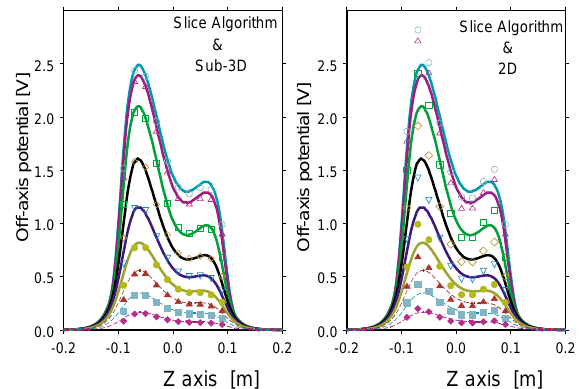
FIG. 11. (Color) On the left-hand side is the longitudinal po- tential of the beam bunch of Fig. 10 inside a metal pipe of ra- dius 2 cm calculated by the slice algorithm of Sec. II (solid and dashed lines) and the sub-3D Poisson solver (symbols) for 0 # r # 2 cm. On the right-hand side are the results of the sub-3D Poisson solver (symbols), but neglecting the ≠ 2 u (cid:3) ≠ z 2 correction